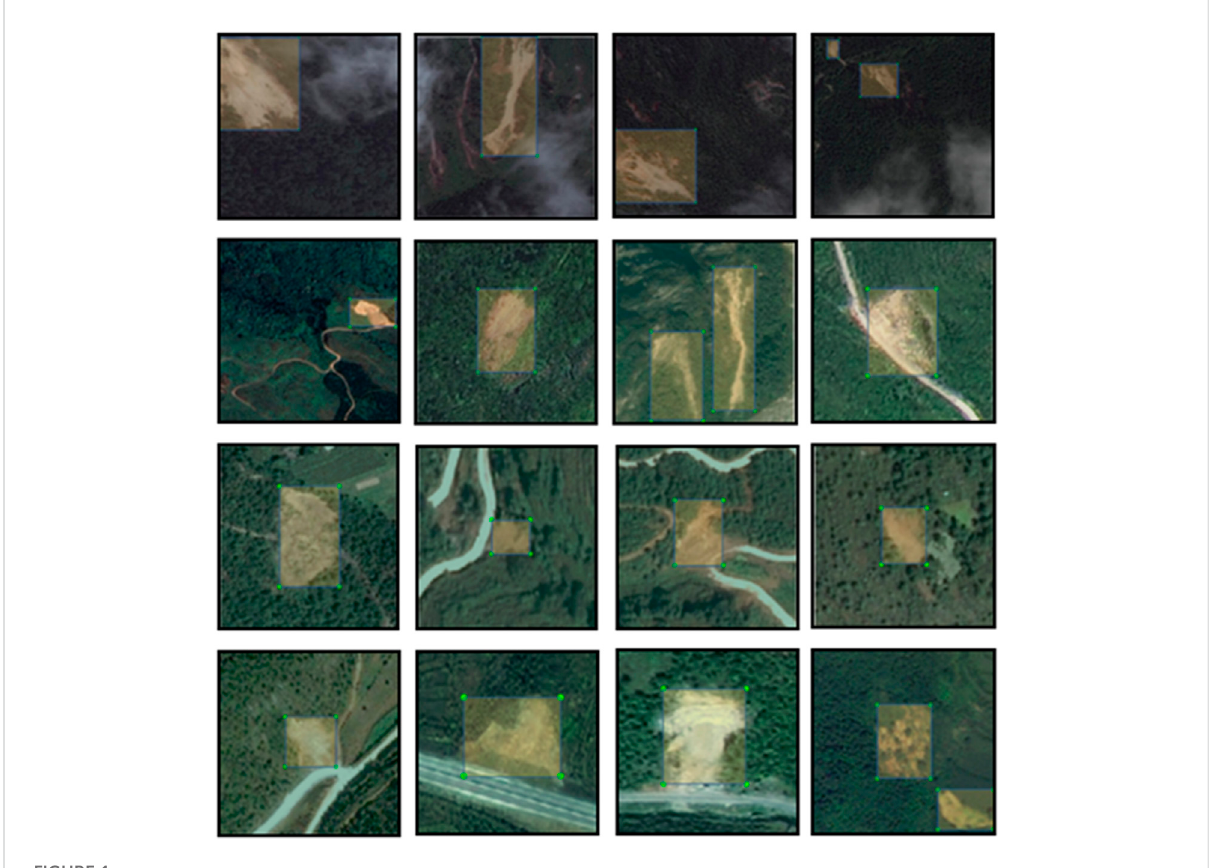
FIGURE 1 Examples of labelled